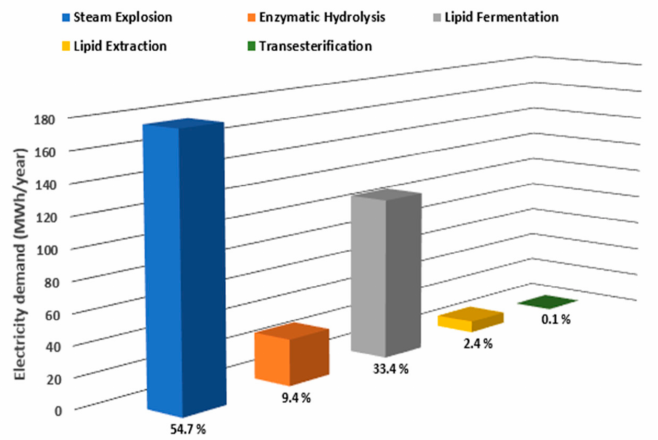
Figure 6. Distribution of electricity needs expressed in MWh/y and considering an operating period of 8000 h/y.